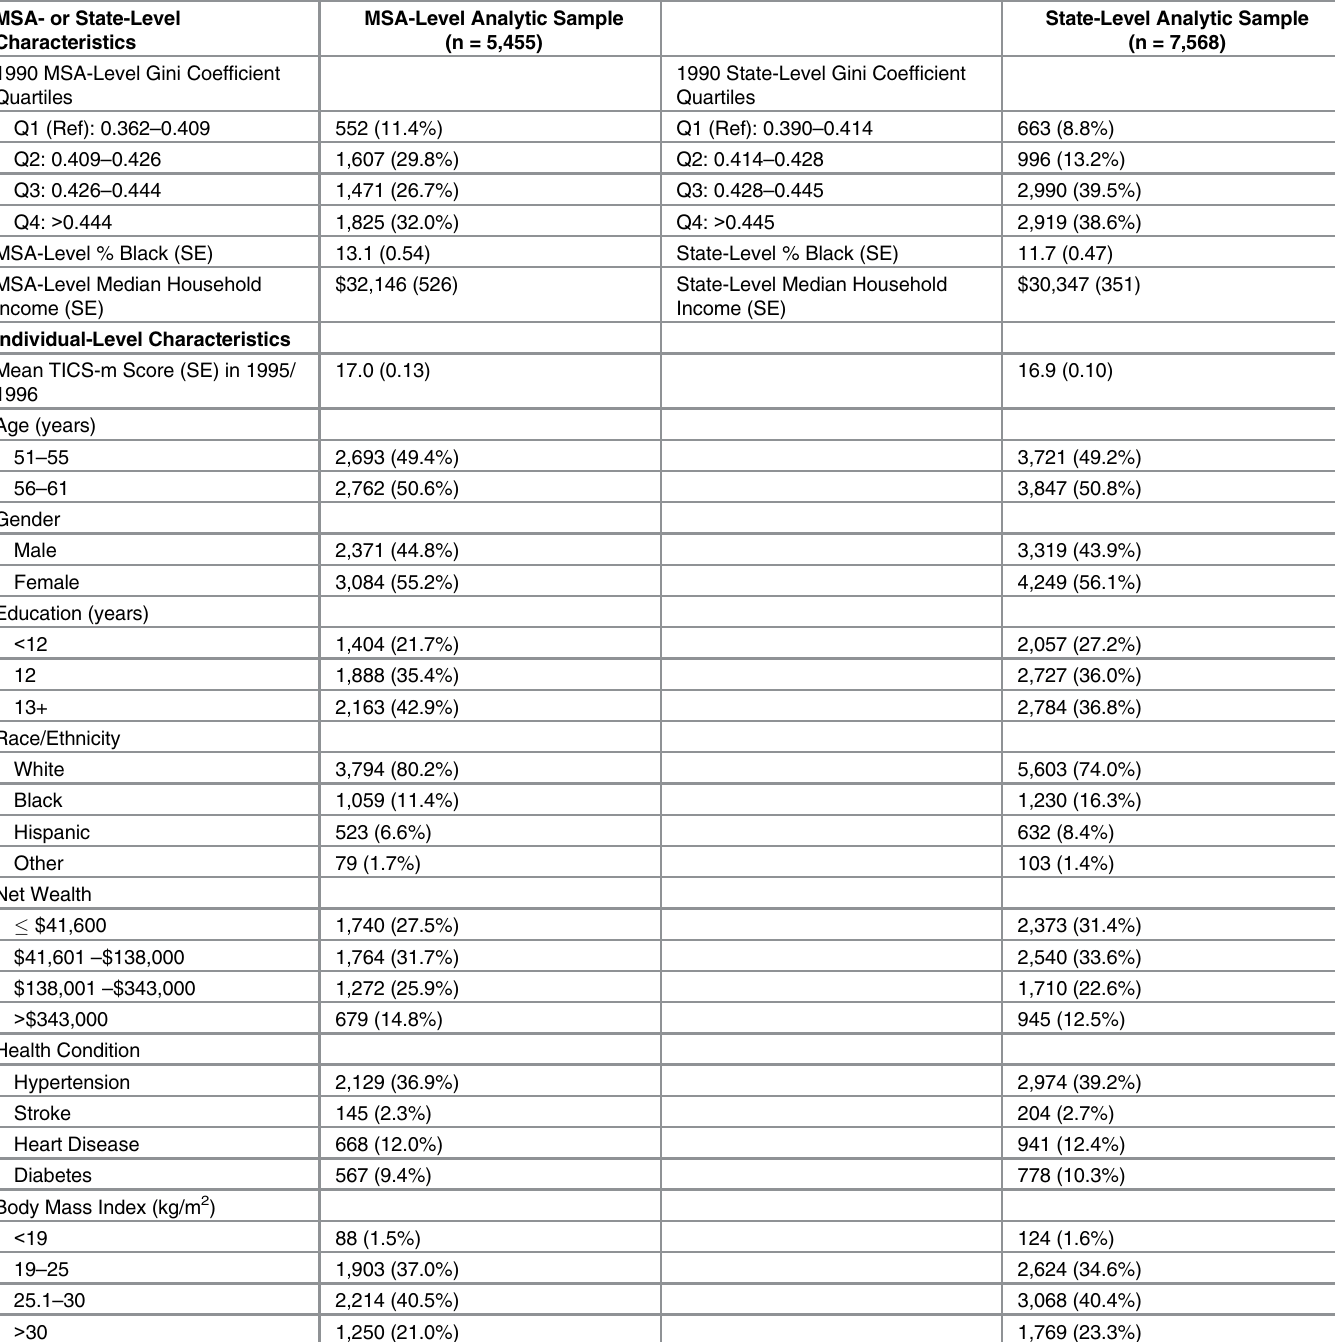
Table 1. Descriptive characteristics of MSA- and state-level analytic samples at baseline (1992), Health and Retirement